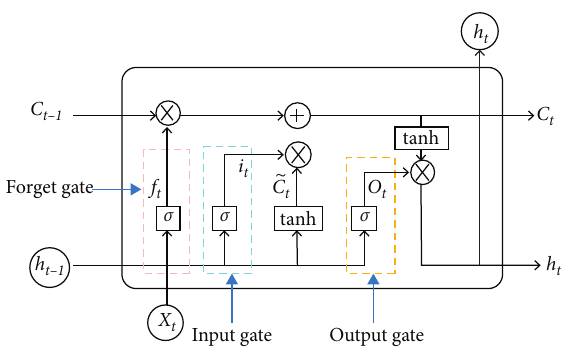
Figure 1: CNN-LSTM structure